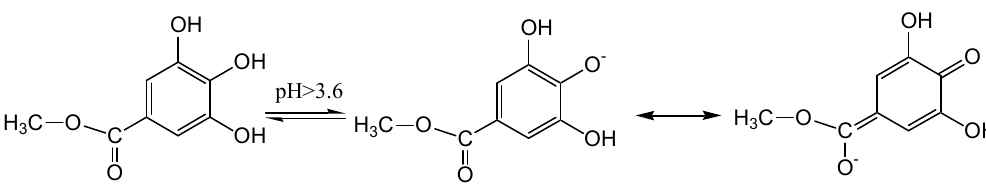
Figure 4. Computed transitions (vertical line) and experimental spectrum (curve) for ( A ) free methyl gallate, ( B ) 7-OH deprotonated methyl gallate, and ( C ) quinoid methyl gallate.